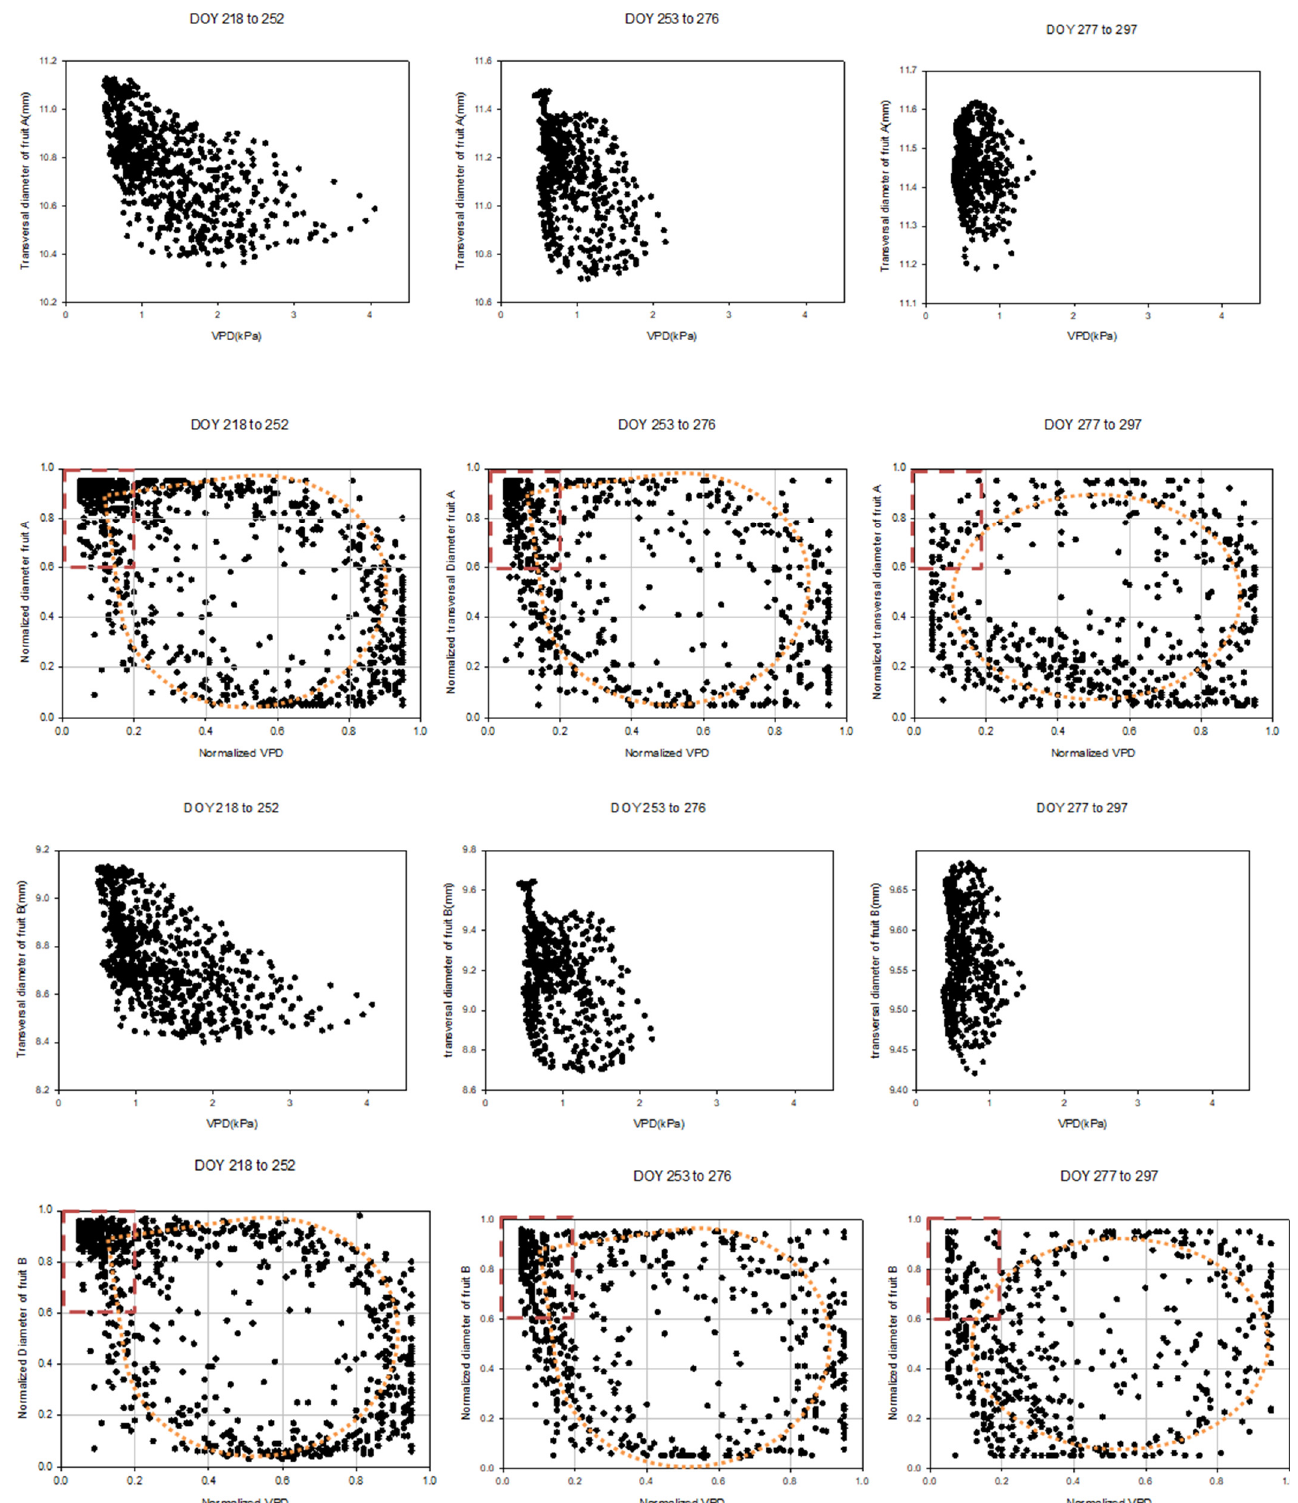
Figure 10. VPD versus transversal diameter for fruits A and B in both periods (first and second) of the experiment. The red box shows the area with minimum VPD and maximum transversal diameter. The orange dotted line shows almond shapes for both parts of the first period of the experiment and oval shapes for the second part.